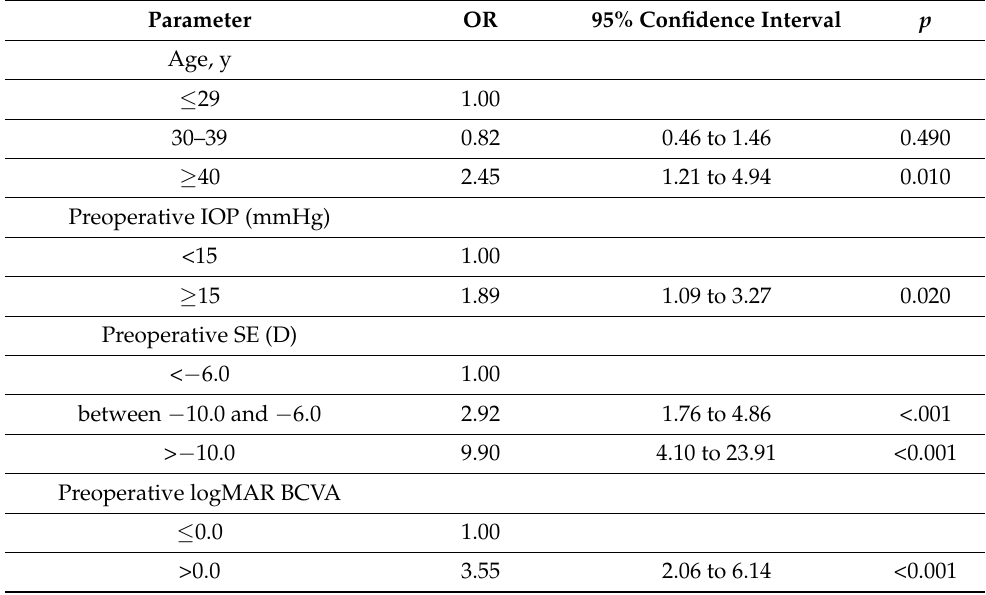
Table 4. Univariate logistic regression analysis to assess the predictor variables of low postoperative efficacy.